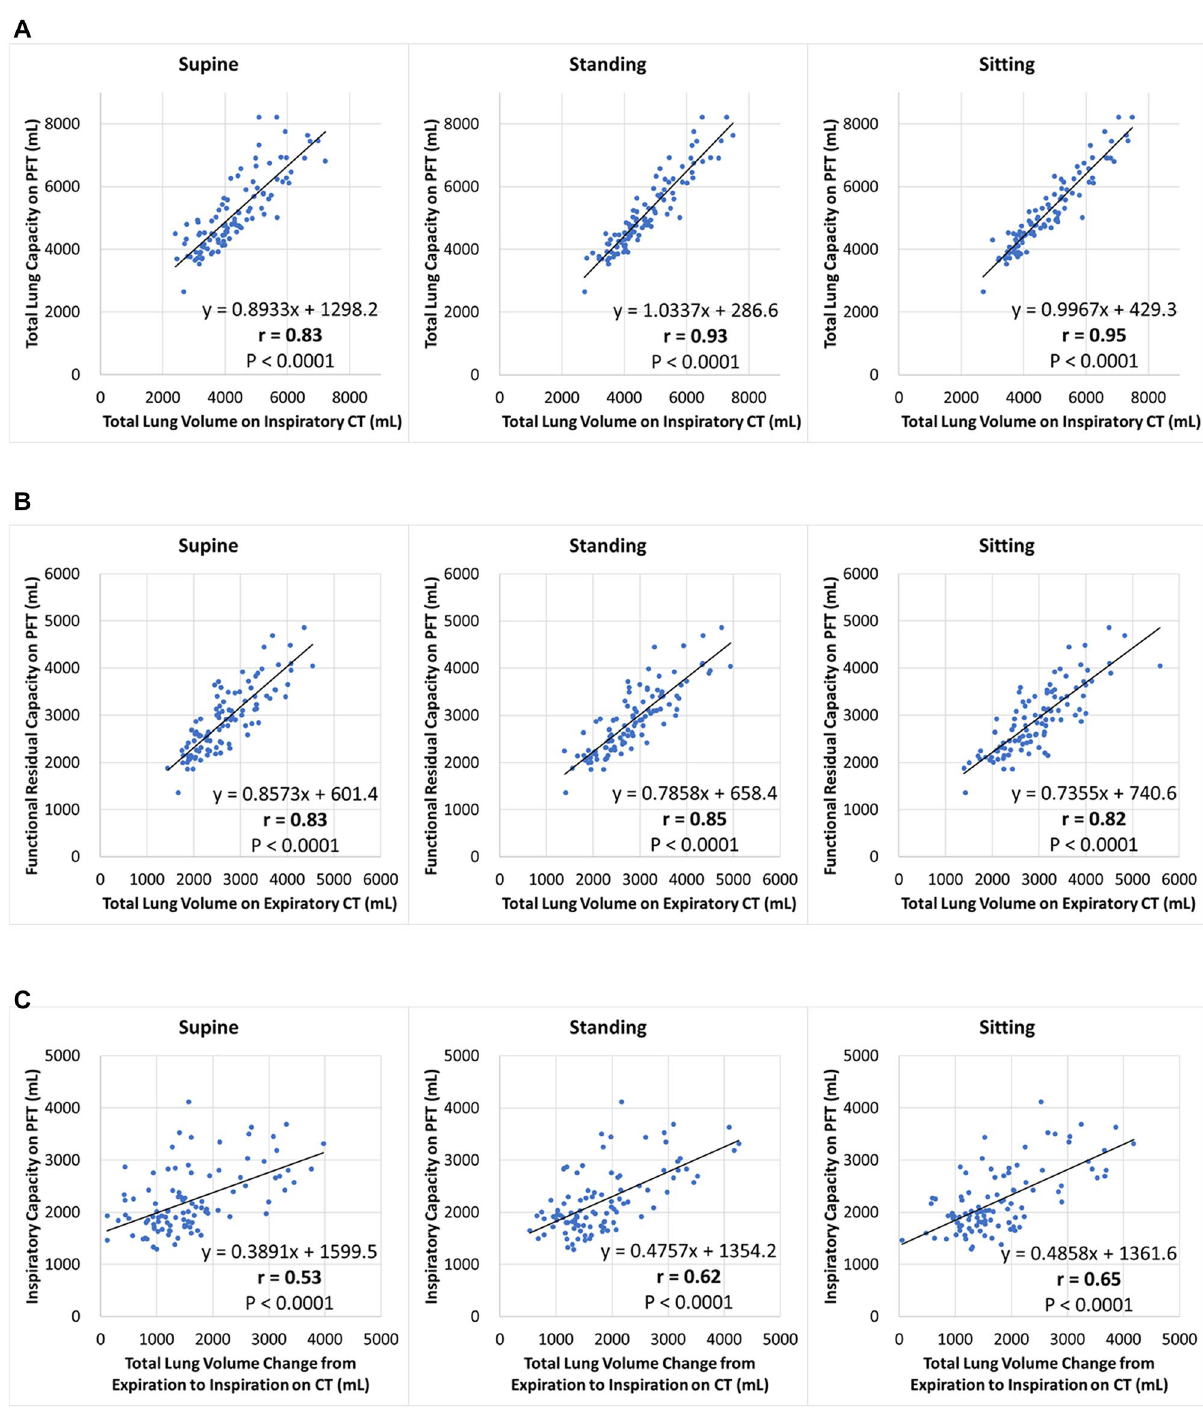
Figure 3. Association between total lung volumes on inspiratory CT in the supine/standing/sitting positions and the total lung capacity on PFT ( A ), association between total lung volumes on expiratory CT in the supine/standing/sitting positions and the functional residual capacity on PFT ( B ), and association between total lung volume changes from expiration to inspiration on CT in the supine/standing/sitting positions and the inspiratory capacity on PFT ( C ), using Pearson correlation coefficient test. ( A – C ) Lines show estimated